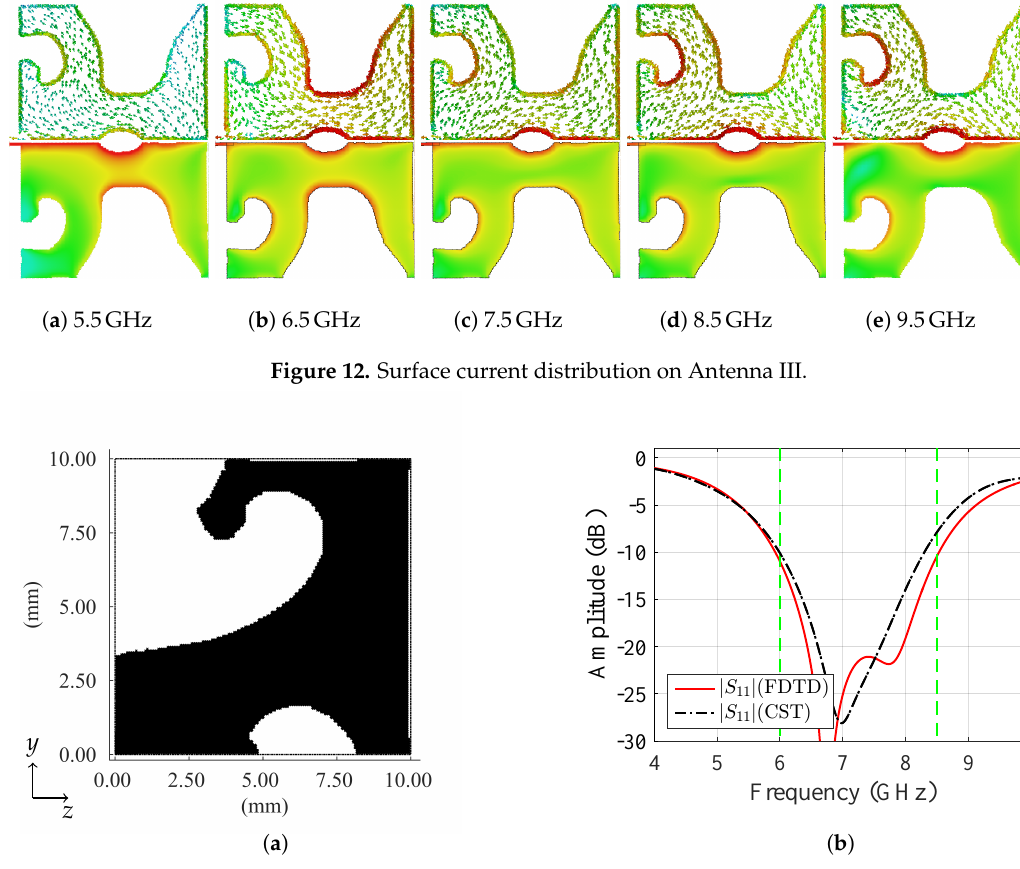
Figure 13. Antenna IV: ( a ) The shape of the antenna optimized to radiate over the frequency band 6.0–8.5 GHz and to filter the frequencies 3.5–6.0GHz and 8.5–11.0GHz. ( b ) The antenna reflection coefficient. The operational band is marked by the green dashed